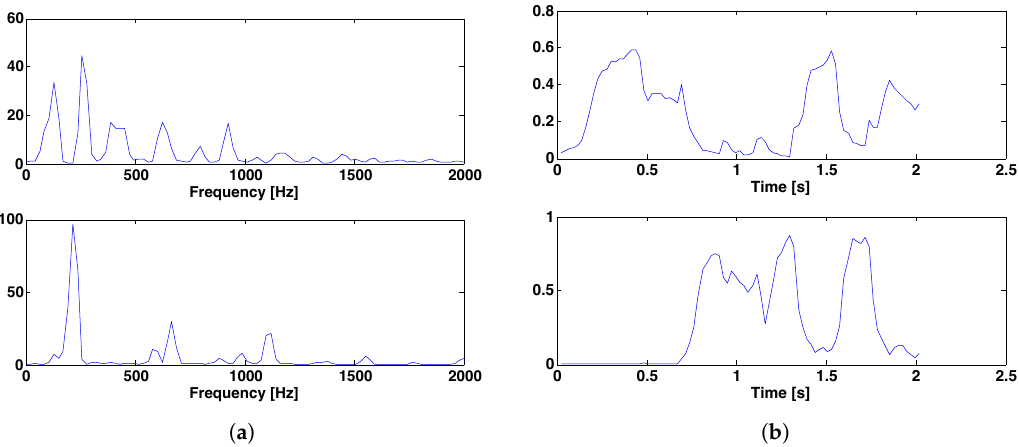
Figure 4. Example of the NMF analysis results for ( a ) the column vectors of W and ( b ) the row vectors of H when the NMF is excessively